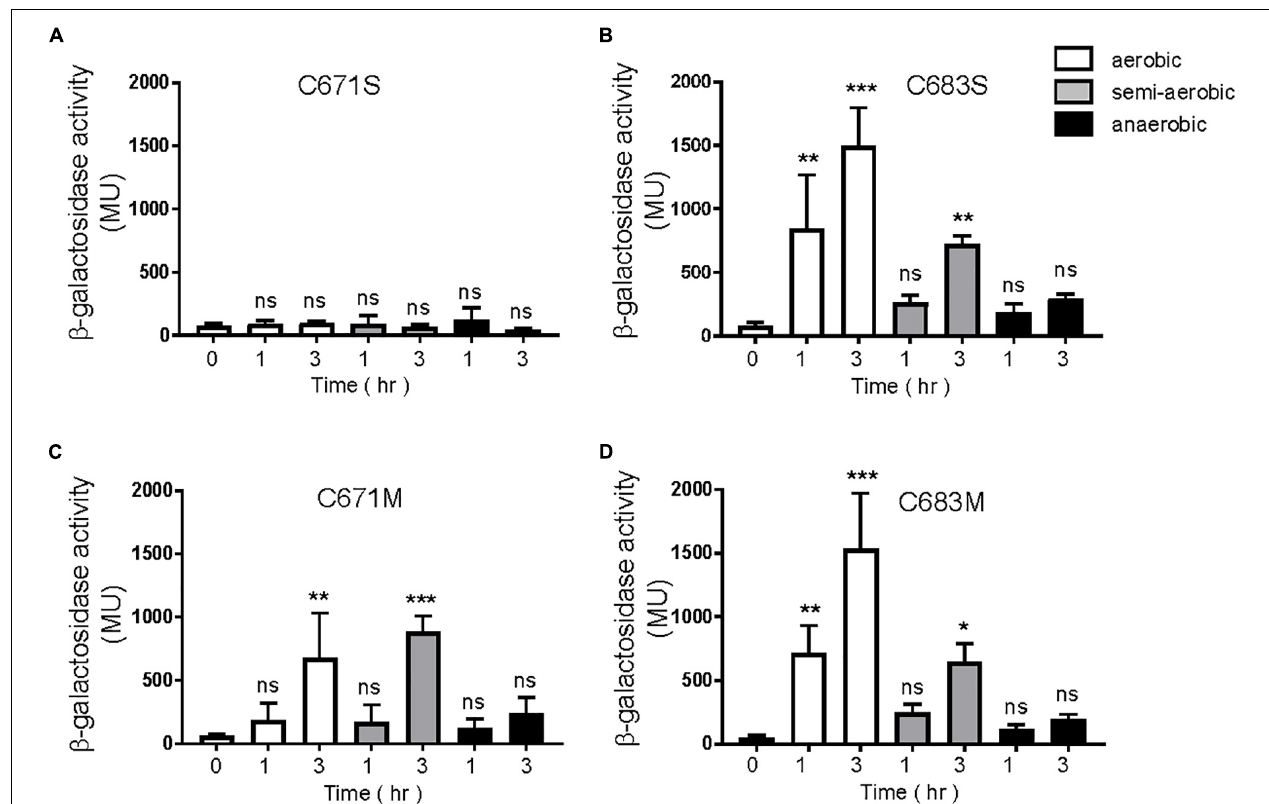
FIGURE 6 | Response to aeration in EvgS-PAS mutants. (A) MG1655 evgS ydeP-lacZ/ pBADevgS C671S; (B) MG1655 evgS ydeP-lacZ/ pBADevgS C683S; (C) MG1655 evgS ydeP-lacZ/ pBADevgS C671M; (D) MG1655 evgS ydeP-lacZ/ pBADevgS C683M. Activity of the ydeP-lacZ reporter in different culturing conditions (upper panels). Cells were grown in EvgS-activation medium with 0.02% arabinose under aerobic (white bars), semi-aerobic (gray bars), or anaerobic condition (black bars) at 37 ◦ C. Optical density at 600 nm of the cell cultures subjected to reporter assays is shown in Supplementary Figure 8 . Data represent the average of three biologically independent replicates. Error bars indicate the standard deviation, and statistical analyses of each redox condition group were performed as described in Figure 1 . ns, not significant; *0.01 ≤ p < 0.05; **0.001 ≤ p < 0.01; *** p < 0.001.